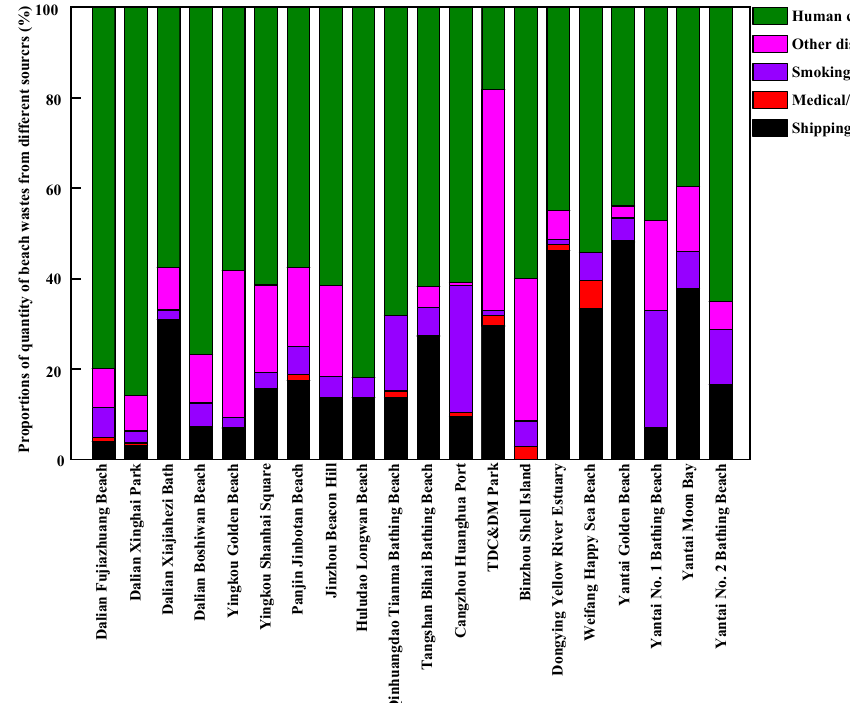
Figure 7. The proportions of beach waste from different sources in coastal cities around the Bohai Sea of China in the tourist off-peak season, by quantity.